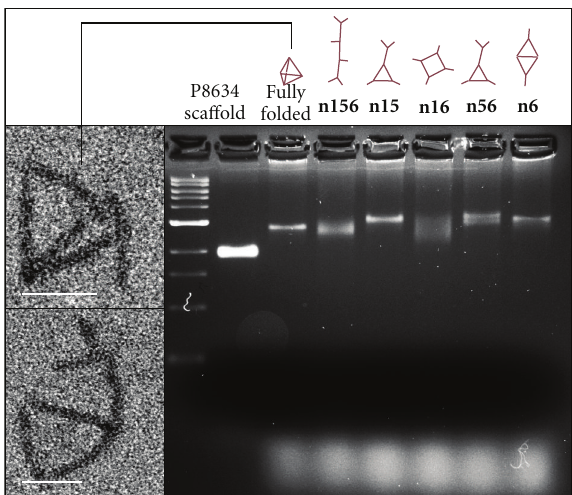
Figure 2: (Left) Transmission electron microscopy (TEM) imaging of tetrahedron structure containing all staple nucleotides. Typically, tetrahedrons displayed one or more ruptured struts, generating the widely observed flattened configuration. Scale bars: 60 nm. (Right) Agarose gel electrophoresis separation of the di ff erent configurations formed by targeted gap staple omission in struts 1, 5, and 6. Left to right: lanes 1-2 contain a 1kb ladder and the circular p8634 sca ff old, respectively. Lanes 3–8 contain the full tetrahedron, and the open configurations n156 , n15 , n16 , n56, and n6 , as indicated by the sketched representations above each